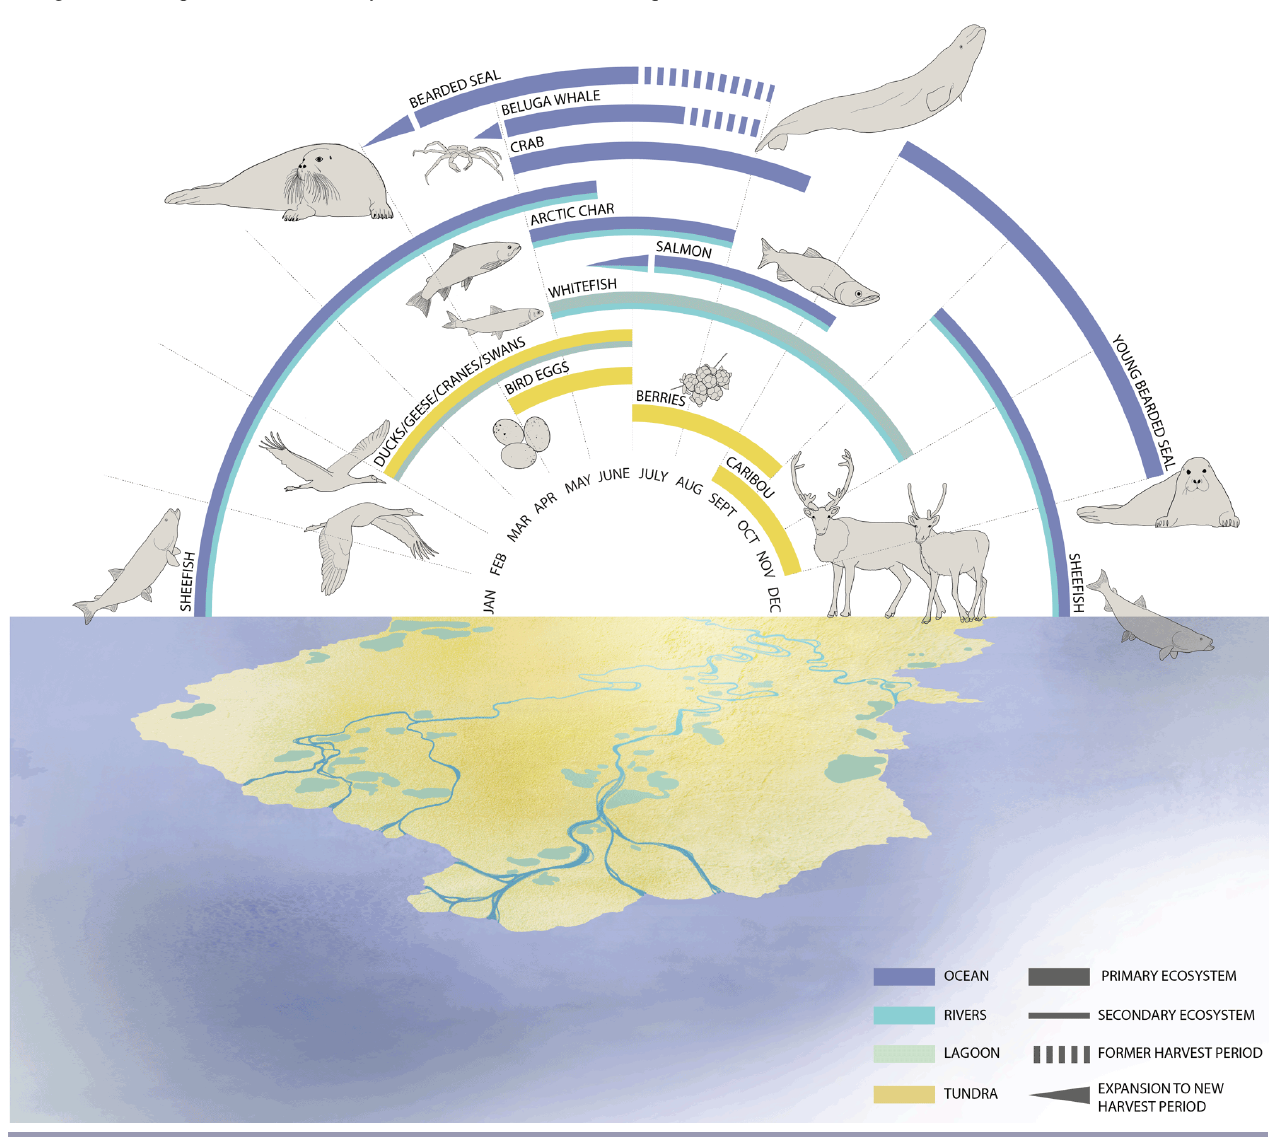
Fig. 3 . Seasonal changes in the harvest of coastal plants and animals in Northwest Arctic Alaska from subsistence harvester interviews in Kotzebue, Alaska, in response to the question, “What months do you harvest coastal species now, and has that changed from the past?” Illustration by Cecil Howell and used with